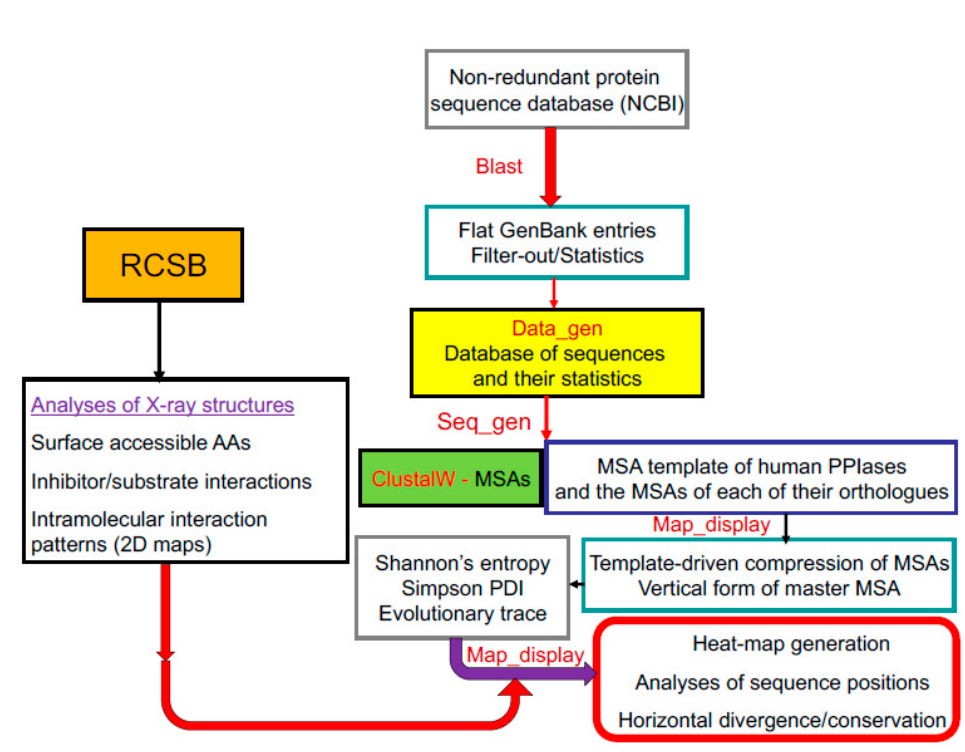
Figure A1. Overall schema of programs used in this note